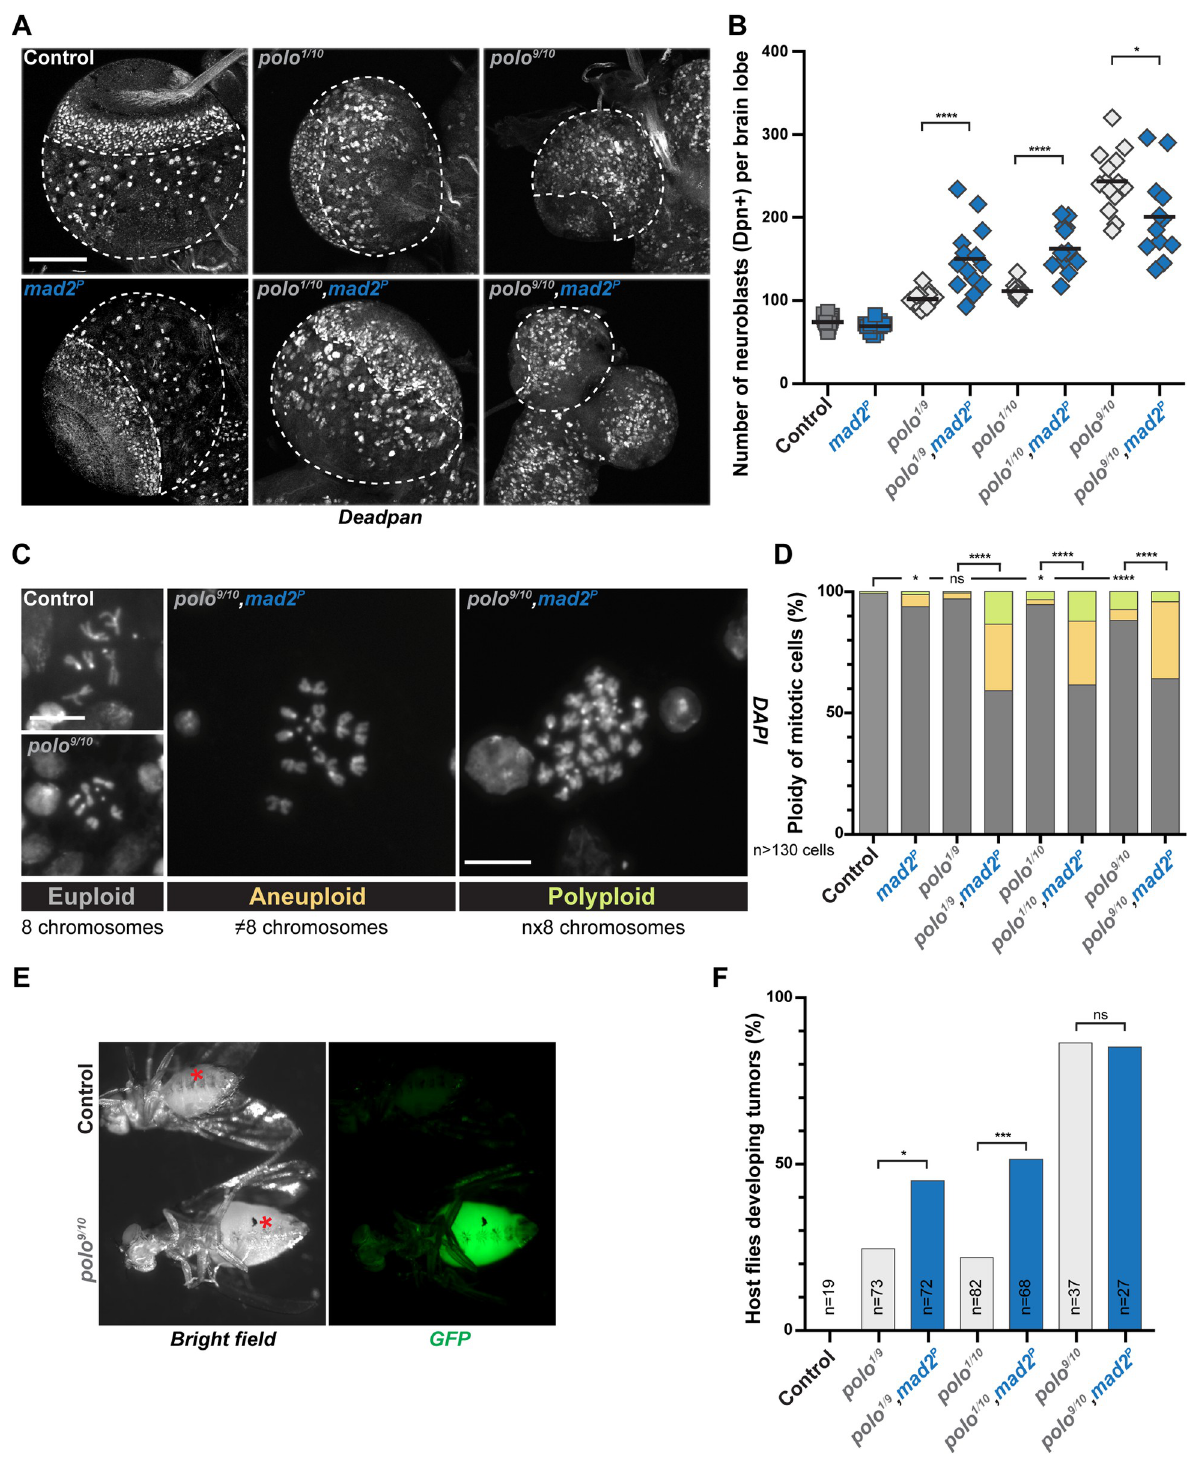
Fig 4. Impairing the SAC in polo mutants induces aneuploidy and promotes tumor growth. A) Representative images of larval brain lobes of the indicated genotypes stained for the NSC marker Deadpan. The white dashed lines outline the central brain area where NSCs were scored. Note the reduced brain lobe size in the polo 9/10 mutant. Scale bar: 100 μ m. B) Quantifications of Deadpan-positive NSCs per brain lobe for the indicated genotypes. Mann-Whitney unpaired test: � : p < 0.05; ���� : p < 0.0001. Means are shown in black. C) Representative images of the three classes of mitotic figures observed from squashed brains stained with DAPI: euploid (8 chromosomes), aneuploid (more or less than 8 chromosomes) and